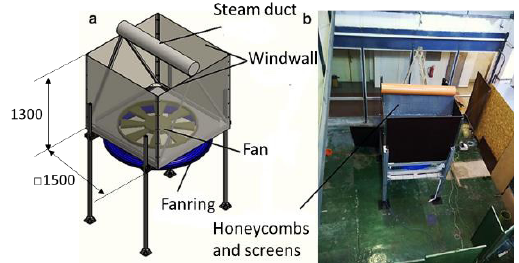
Fig. 1. Model of one cell ACC